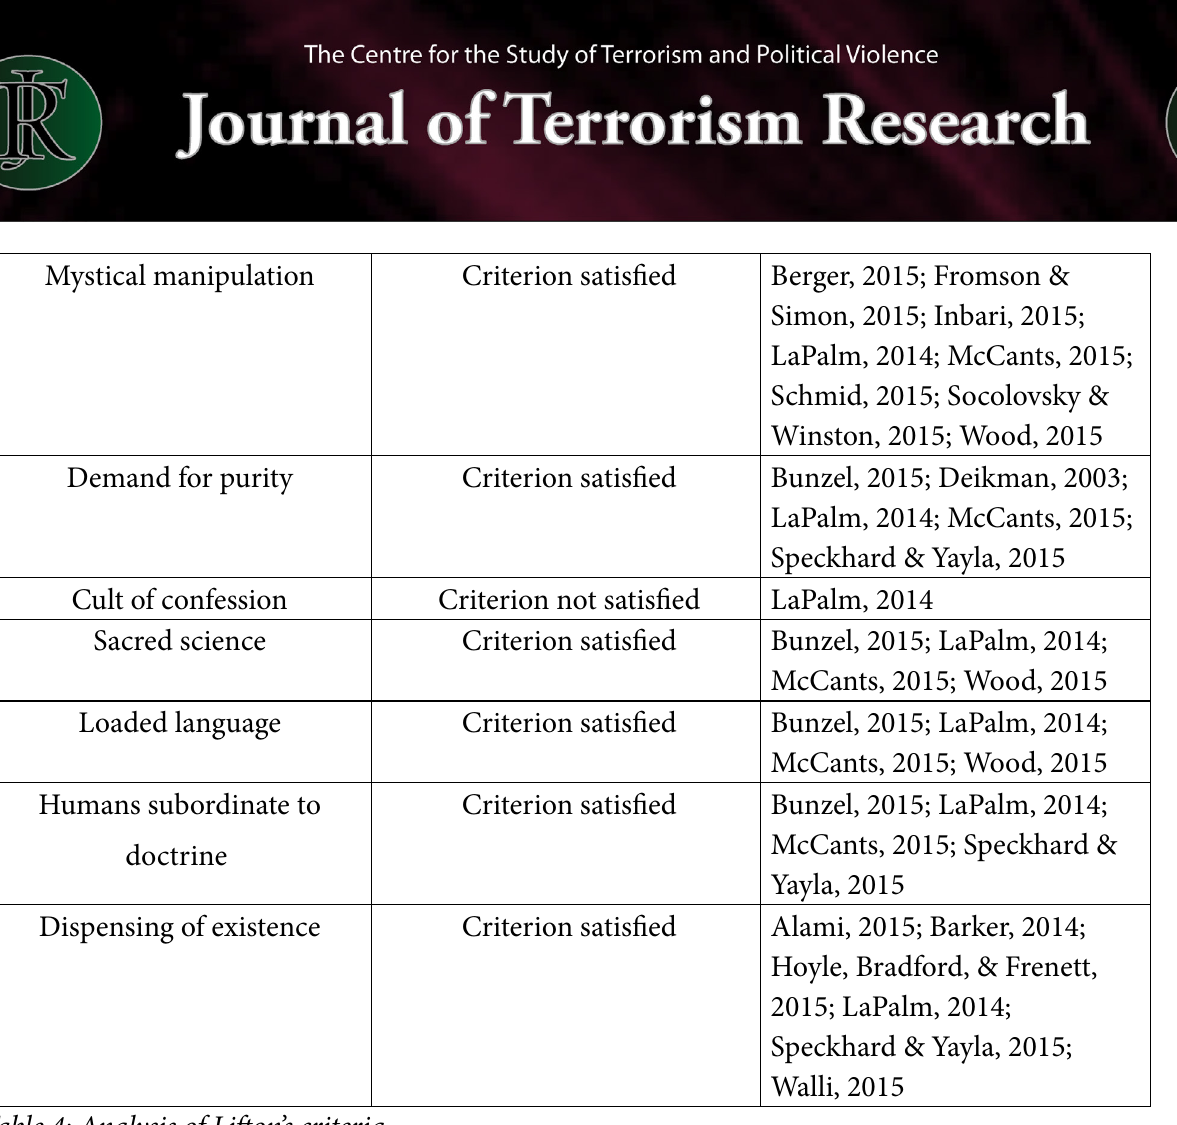
Table 4: Analysis of Lifton’s criteria The evidence reveals ISIS satisfies Lifton’s criteria with one exception (i.e. confession). This outcome